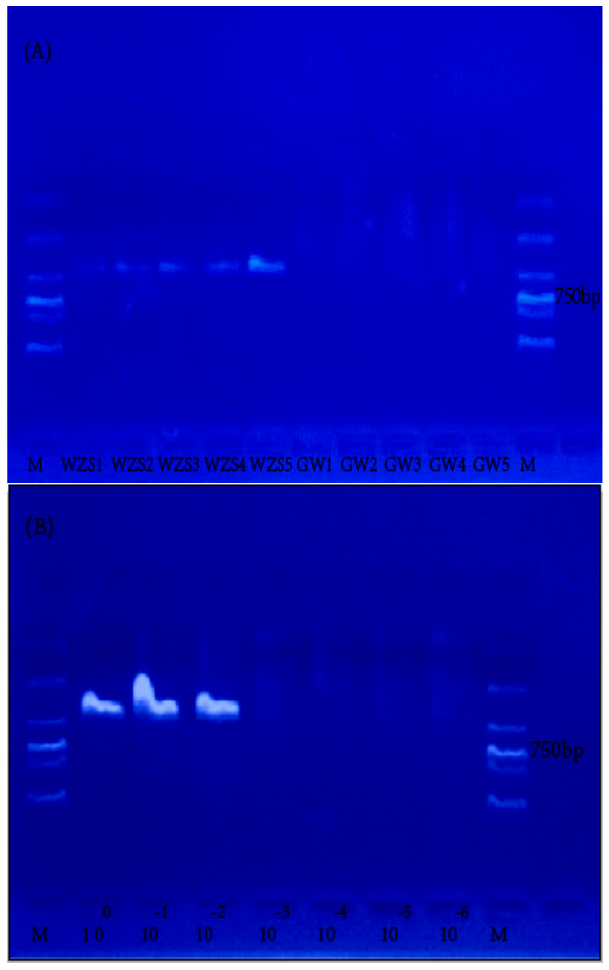
Figure 2. Results of specificity and sensitivity for the BAR-RPA assays. ( A ) Five samples for each species, F. hirta (WZS-1~WZS-5) and G. elegans (GW-1~GW-5) were tested for the specificity of the BAR-RPA assays; ( B ) Sensitivity of the BAR-RPA was assessed with the WZS-2 sample (dilutions: 10 0 , 10 − 1 , 10 − 2 , 10 − 3 , 10 − 4 , 10 − 5 , and 10 − 6 ng/ µ